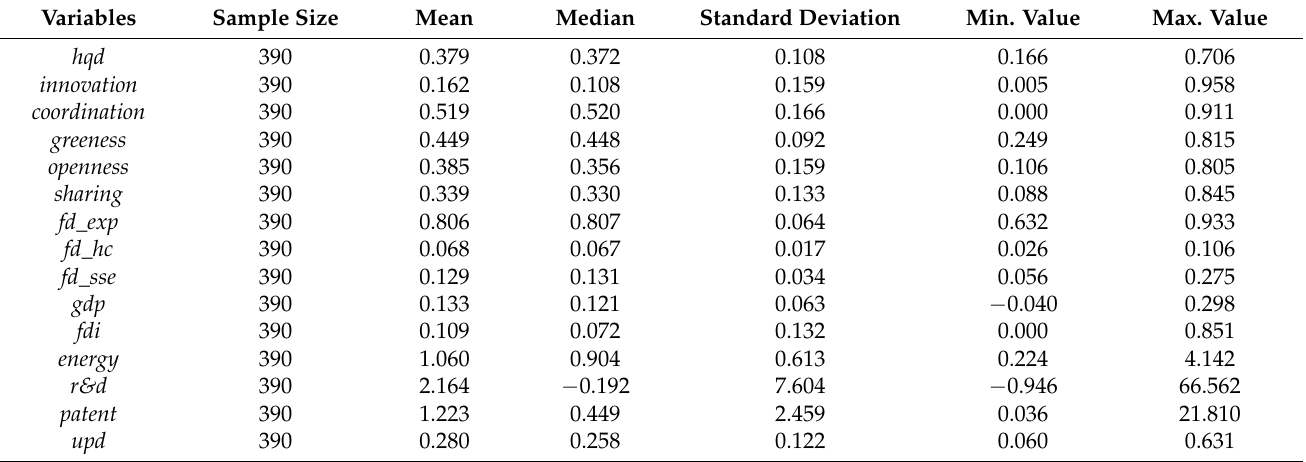
Table 2. Descriptive statistics for